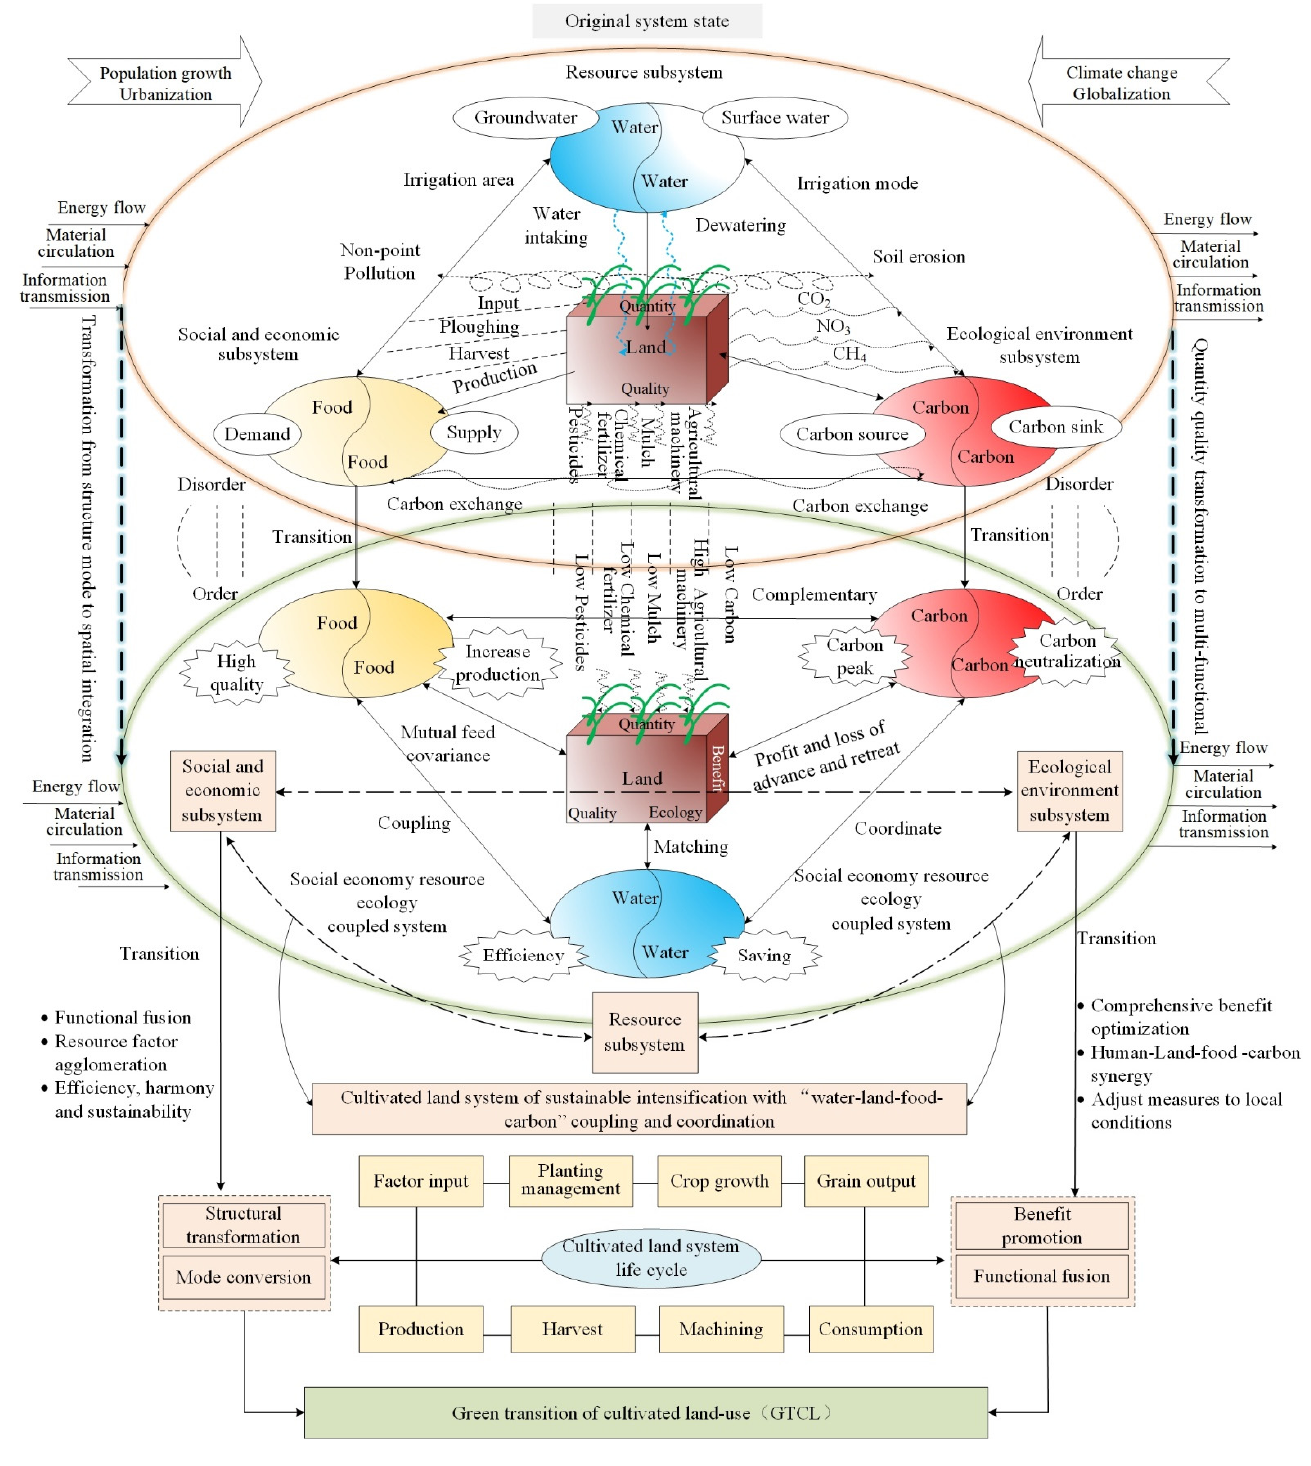
Figure 2. The concept framework of GTCL.